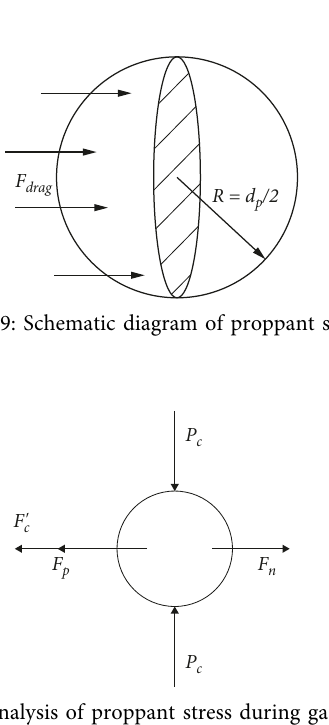
Figure 8: Schematic diagram of the calculation model of drag force.